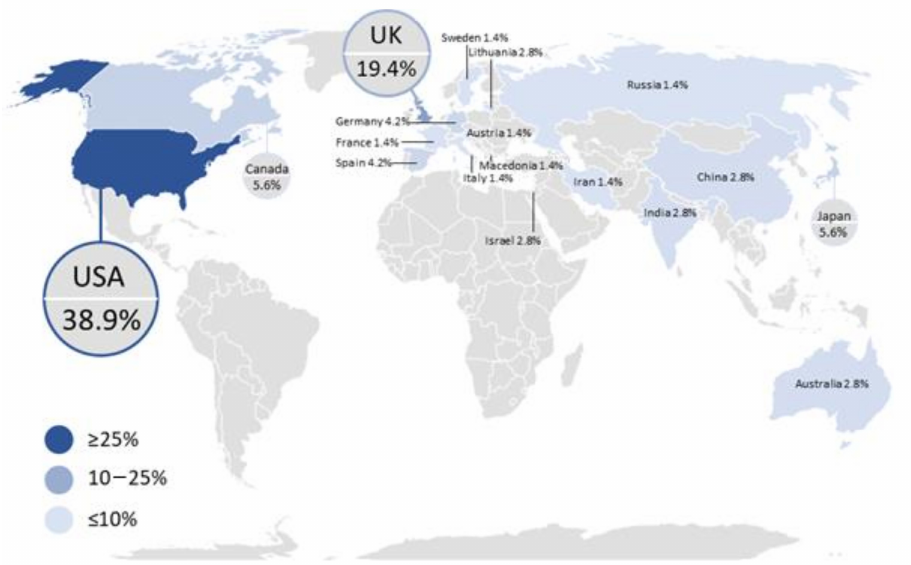
Figure 2. Global distribution of scientific articles that discussed the use of near-infrared spectroscopy (NIRS) technology in traumatic brain injury (TBI) monitoring until July 2020. The number of publications per country is indicated by the intensity of the color, with darker colors representing a higher number of articles than lighter